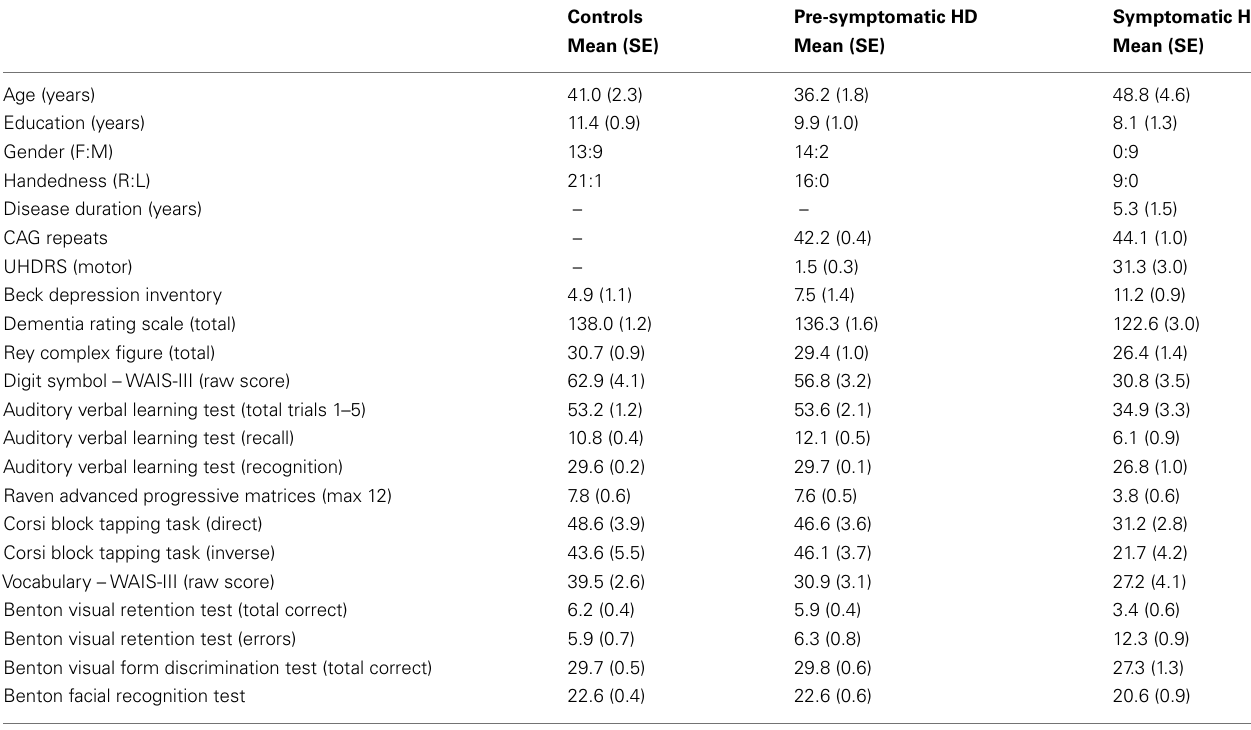
Table 1 | Characteristics of the pre-symptomatic and symptomatic HD patients and the control